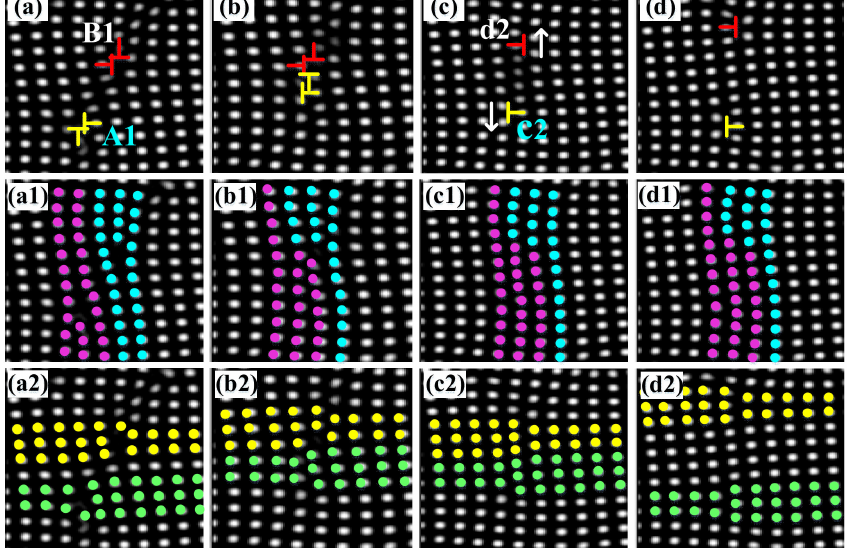
Figure 9. Type II semi-annihilation of dislocations on A1 and B1 in Figure 7c. The ( a – d ) corresponding time steps are t * = 48,200; t * = 48,300; t * = 48,400; and t * = 48,700. ( a1 – d1 ) is the atomic structure in the x direction; ( a2 – d2 ) is a schematic diagram of the atomic structure in the y